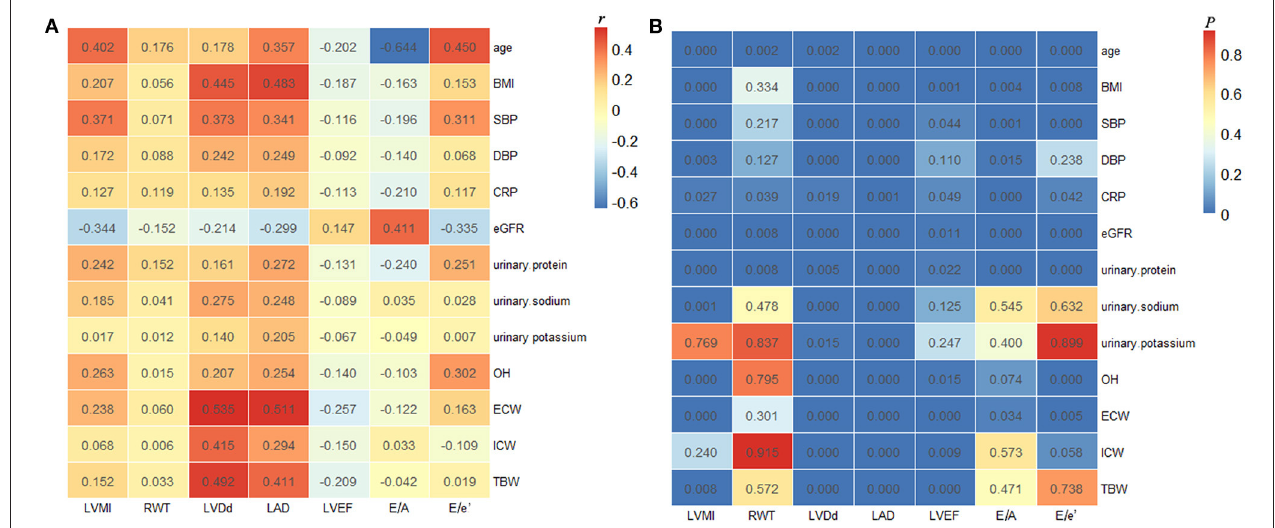
FIGURE 2 | Correlations between echocardiographic findings and clinical and laboratory parameters. The correlation coefficients (A) and P- values (B) of Spearman correlation analyses in all the enrolled patients. LVMI, left ventricular mass index; RWT, relative wall thickness; LVDd, left ventricular end-diastolic dimension; LAD, left atrial dimension; LVEF, left ventricular ejection fraction; BMI, body mass index; SBP, systolic blood pressure; DBP, diastolic blood pressure; CRP, C-reactive protein; eGFR, estimated glomerular filtration rate; OH, overhydration; ECW, extracellular water; ICW, intracellular water; TBW, total body